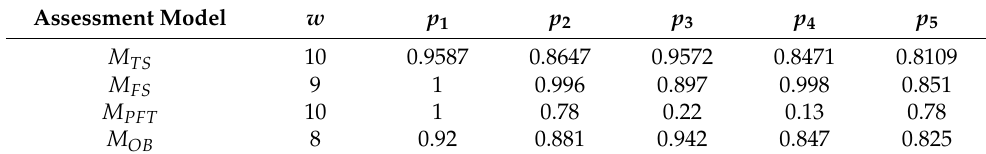
Table 6. Data of output estimates obtained based on models M TS , M FS , M PFT ,and M OB . Assessment